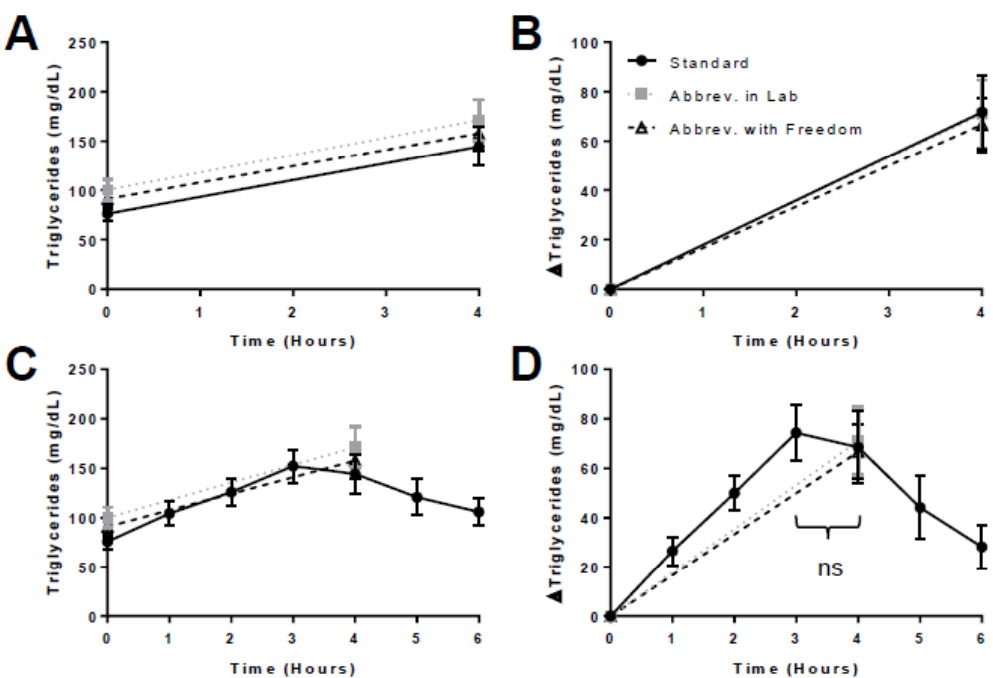
Figure 2. Postprandial triglyceride responses in the 3 meal trials. For clarity, postprandial triglyceride data are presented in four ways ( A,B,C,D ), varying whether data are normalized for fasting values (Panels B , D ) and overlaid with hourly data from the SL trial (Panels C , D ). There were no significant differences in the postprandial triglyceride response across the 3 trials. Additionally, “ns” denotes that there was no difference between the 3-h and 4-h triglyceride levels in the SL